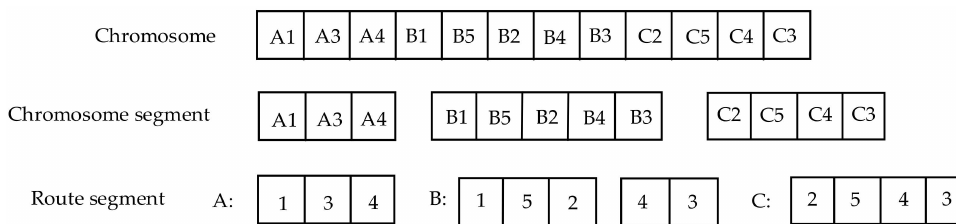
Figure 3. One example of a